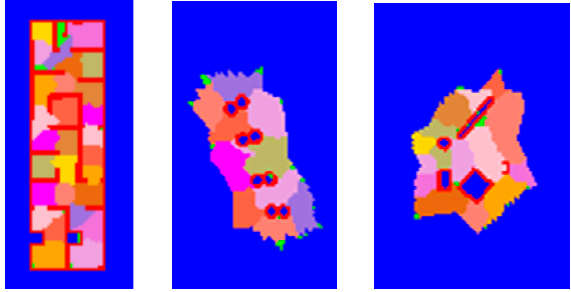
Figure 10. Topological maps saved in three environments.